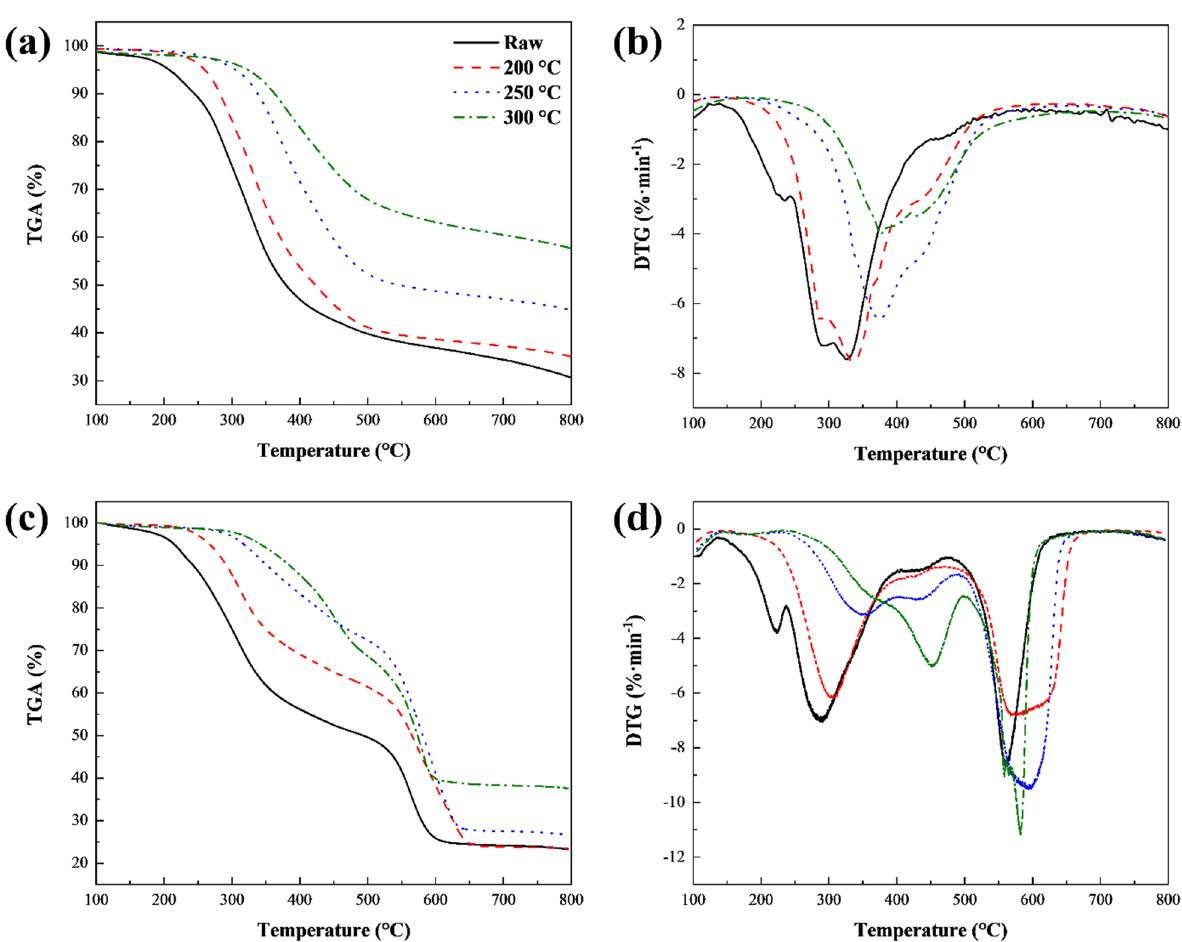
Fig. 6 Pyrolysis ( a ) TGA and ( b ) DTG curves as well as combustion ( c ) TGA and ( d ) DTG curves of raw and torrefied